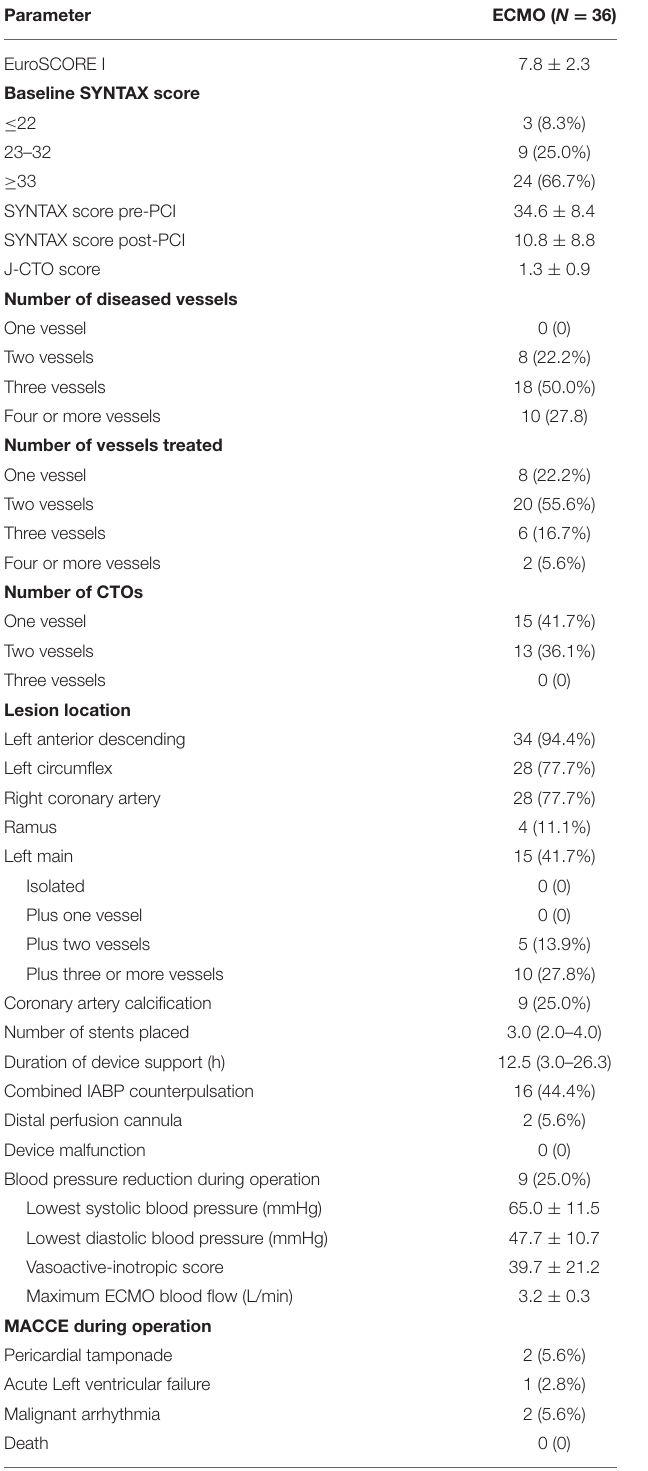
TABLE 3 | Comparison of laboratory and cardiac function parameters before and after PCI.